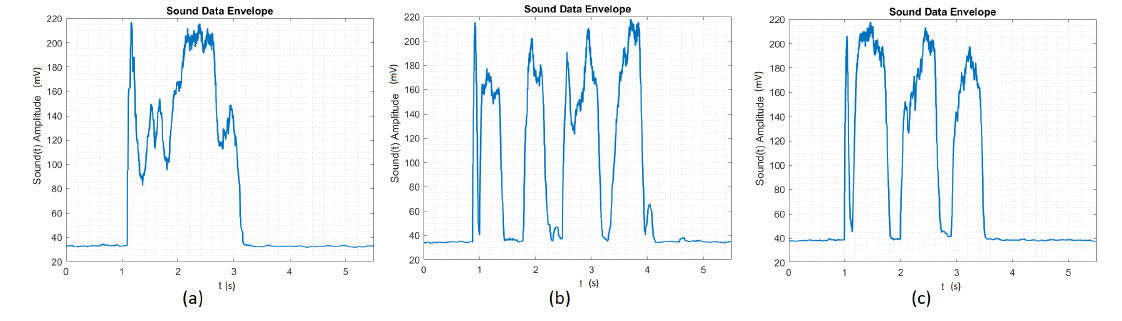
Figure 4. ( a ) Envelope time signal for the Circle. ( b ) Envelope time signal for the Square. ( c ) Envelope time signal for the Triangle.